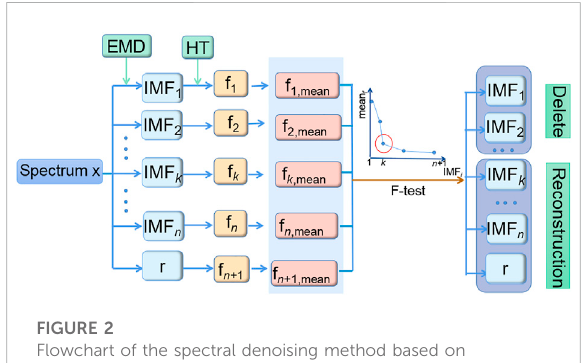
FIGURE 2 Flowchart of the spectral denoising method based on Hilbert – Huang transform combined with the